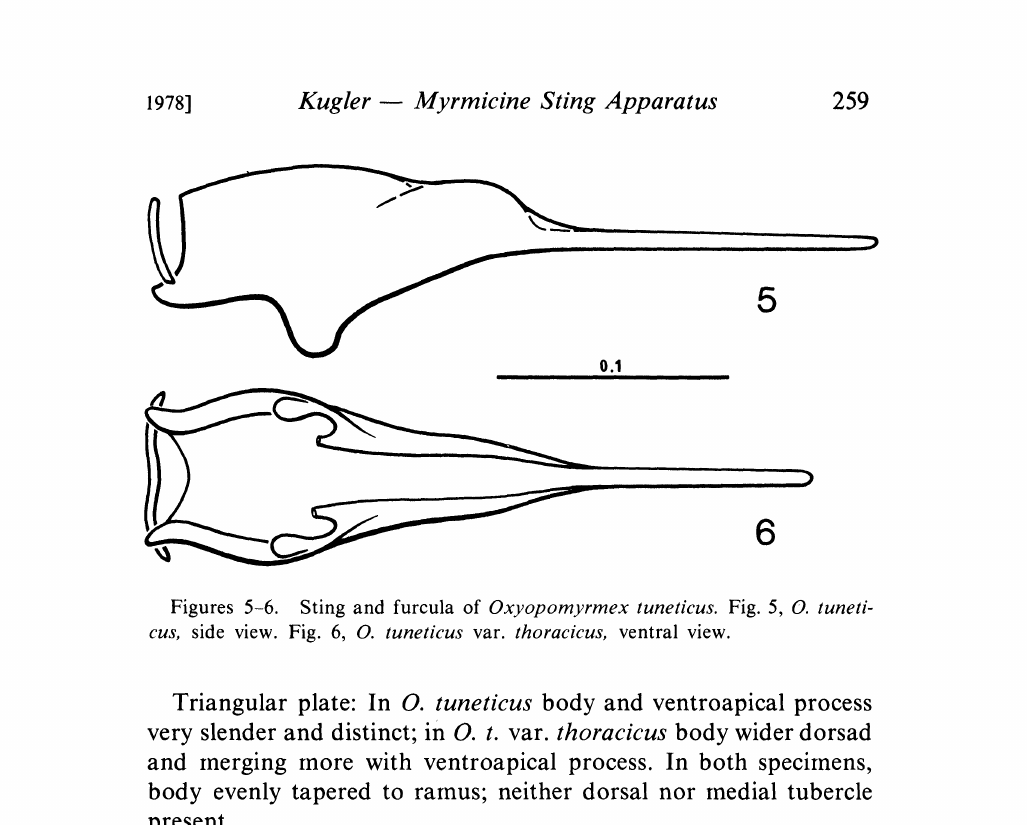
Furcula: (Figs. 5, 6) Slender arch, uniforn in diameter; no dorsal